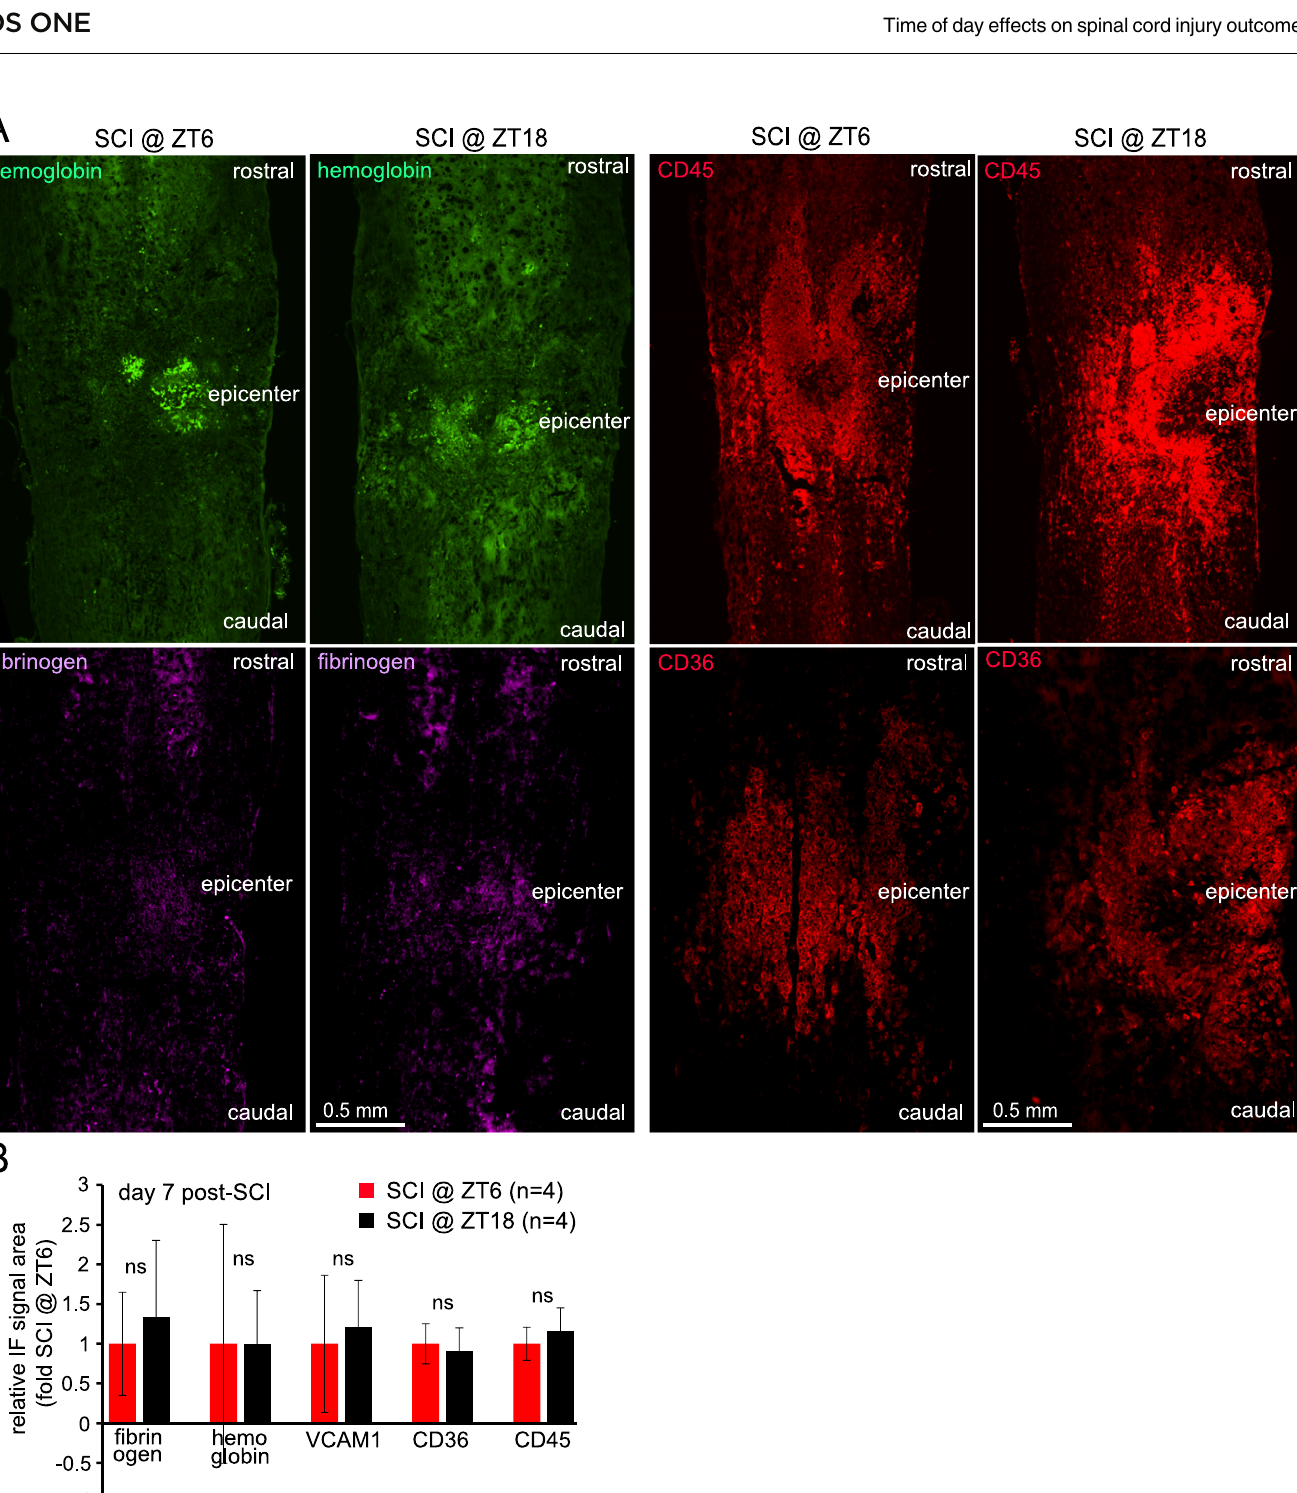
Fig 4. Similar expression of markers of hemorrhage, BSCB disruption and neuroinflammation at 1 week after SCI at ZT6 and ZT18. Some mice from study 2 were euthanized at 1 week post injury and markers of hemorrhage (hemoglobin), BSCB disruption (fibrinogen) and neuroinflammation (VCAM1, CD45 and CD36) were evaluated by immunofluorescence using longitudinal sections through the injury epicenter region. A , Representative images depicting marker stainings. B , Quantification of marker staining immunofluorescence (IF) signal area in a 1.5 mm lesion region spanning the injury epicenter (% total lesion area occupied by the positive IF signal). All data are means ± SD; ns, p > 0.05, U